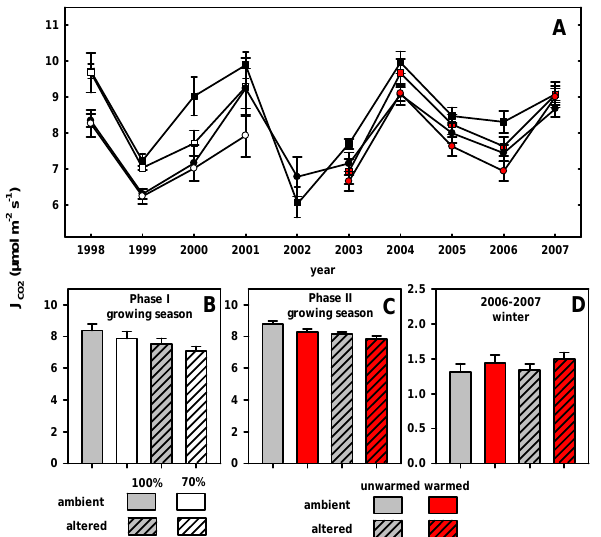
Fig. 7. Soil CO 2 efflux ( J CO ) by rainfall and warming treat- 2 ments. (A) Mean growing season J CO by year, symbols as in 2 Fig. 1. Growing season mean J CO during (B) Phase I and (C) 2 Phase II. (D) Winter J CO by rainfall pattern and warming during 2 2006–2007. Note that scaling for (D) differs from that for (B–C) . Error bars denote 1SE of the mean.